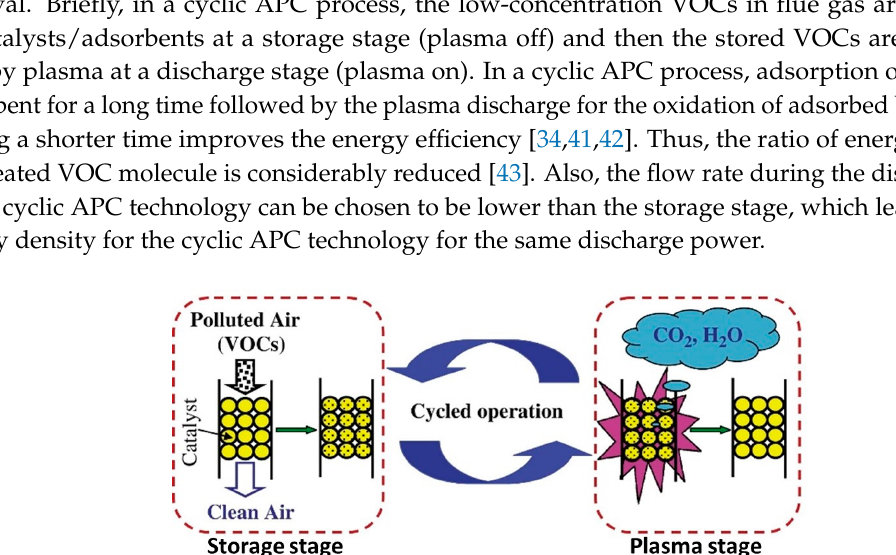
Figure 1. The working principle of the continuous adsorption-plasma catalytic process for volatile organic compounds (VOCs) removal ( a ) in-plasma catalysis and ( b ) post-plasma catalysis. Reprinted from Reference [40], with permission from Elsevier.